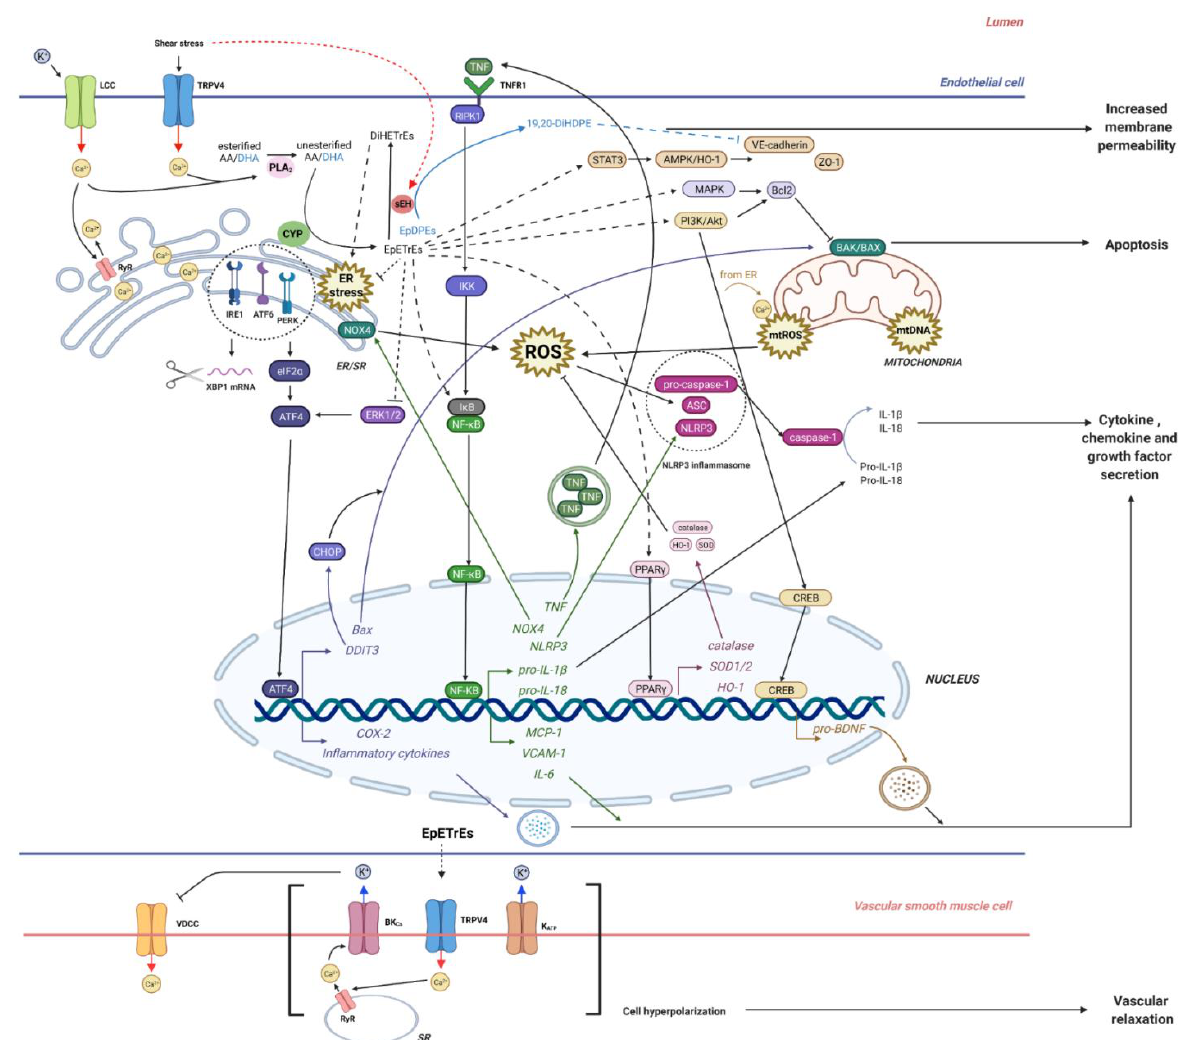
Figure 3. Some potential mechanisms related to effects of the cytochrome P450-soluble epoxide hydrolase (CYP450-sEH) pathway. The vascular endothelial cells release EpETrEs onto the vascular smooth muscle cells, leading to vasodilation. Cell stressors including shear stress, inflammation, metabolic stress, and angiotensin, can interrupt this process; they can exacerbate ER stress in endothelial cells, leading to endothelial dysfunction and vessel inflammation [19,20]. Laminar flow has an anti-inflammatory effect involving PPARg signaling, which is disrupted by shear stress [19]. Shear stress and angiotensin II increase sEH expression [19,20]. Inhibition of sEH attenuates ER stress by an unknown mechanism that may involve elevated epoxides and/or decreased diols, which attenuates production of inflammatory cytokines and chemokines, and membrane permeability [15 – 18,21]. By reducing NFkB-dependent TNF signaling [22], epoxides may reduce the expression of NOX4, which would generate reactive oxygen species (ROS) in the ER, and reduce the expression of NLRP3 inflammasome components, which would exacerbate inflammation [23]. The mitochondria can be activated by Ca 2+ from the ER, generating ROS that activate the inflammasome. Mitochondrial dysfunction can lead to programmed cell death, which can be exacerbated by Bax expression due to ER stress [23]. Therefore, the epoxides and/or diols, and sEH inhibitors, may affect cross-talk between the ER, mitochondria and NLRP3 inflammasome, attenuating inflammation, apoptosis, and the effects of oxidative stress [22 – 24]. Abbreviations: EpETrE, epoxyeicosatrienoic acid; DiHETrE, dihydroxyepoxyeicosatrienoic acid; ER, endoplasmic reticulum; SR, sarcoplasmic reticulum; PPARg, peroxisome proliferator-activated receptor gamma; sEH, soluble epoxide hydrolase; NFkB, nuclear factor kappa B; TNF, tumor necrosis factor; TNFR, tumor necrosis factor receptor; NOX4, NADPH oxidase 4; NLRP3, NOD-, LRR- and pyrin domain-containing protein 3; Bax, Bcl-2-associated X protein; LCC, L-type calcium channel; TRPV4, transient receptor potential vanilloid 4; AA, arachidonic acid; DHA, docosahexaenoic acid; RyR, ryanodine receptors; IRE1, inositol-